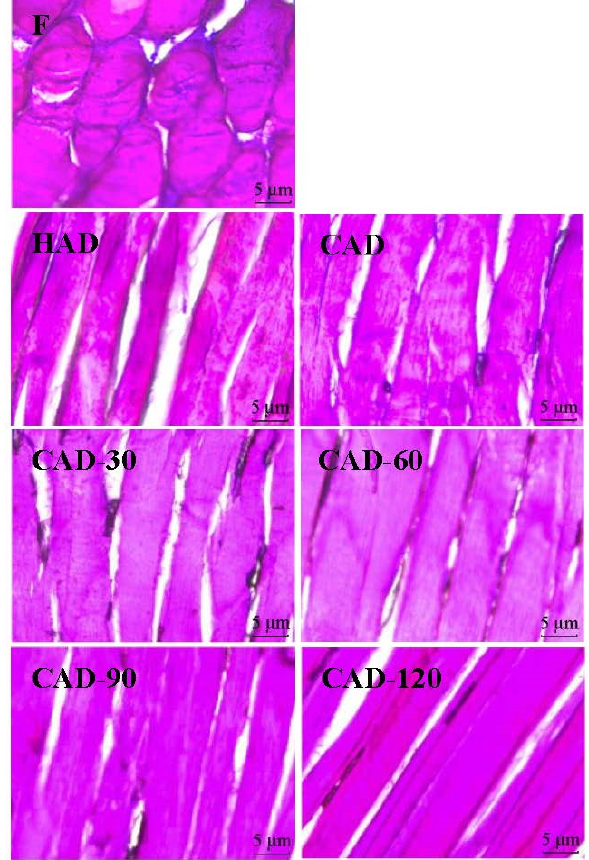
Figure 4. Microstructure (vertical section) of semi-dried pufferfish fillets under different drying methods. F, fresh undried fillets; HAD, hot air drying; CAD, cold air drying; CAD-30, cold air drying for 30 min; CAD-60, cold air drying for 60 min; CAD-90, cold air drying for 90 min; CAD-120, cold air drying for 120 min.